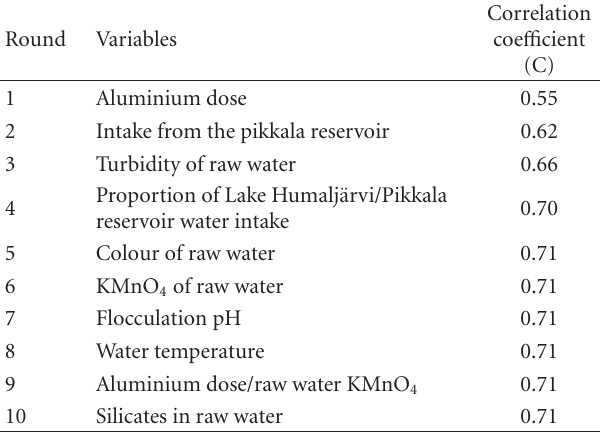
Table 3: Variables selected for turbidity using multiple linear regression.